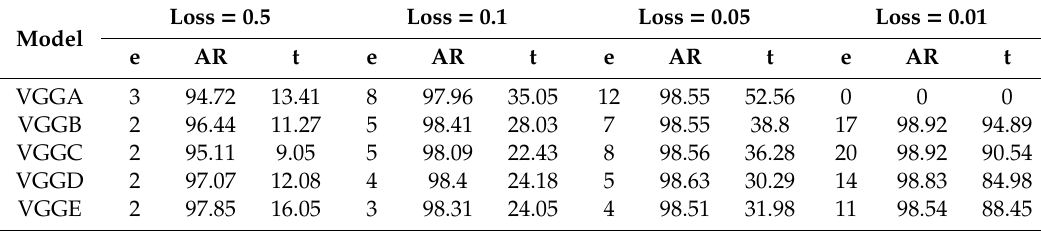
Table 3. Experimental results of the convolutional network